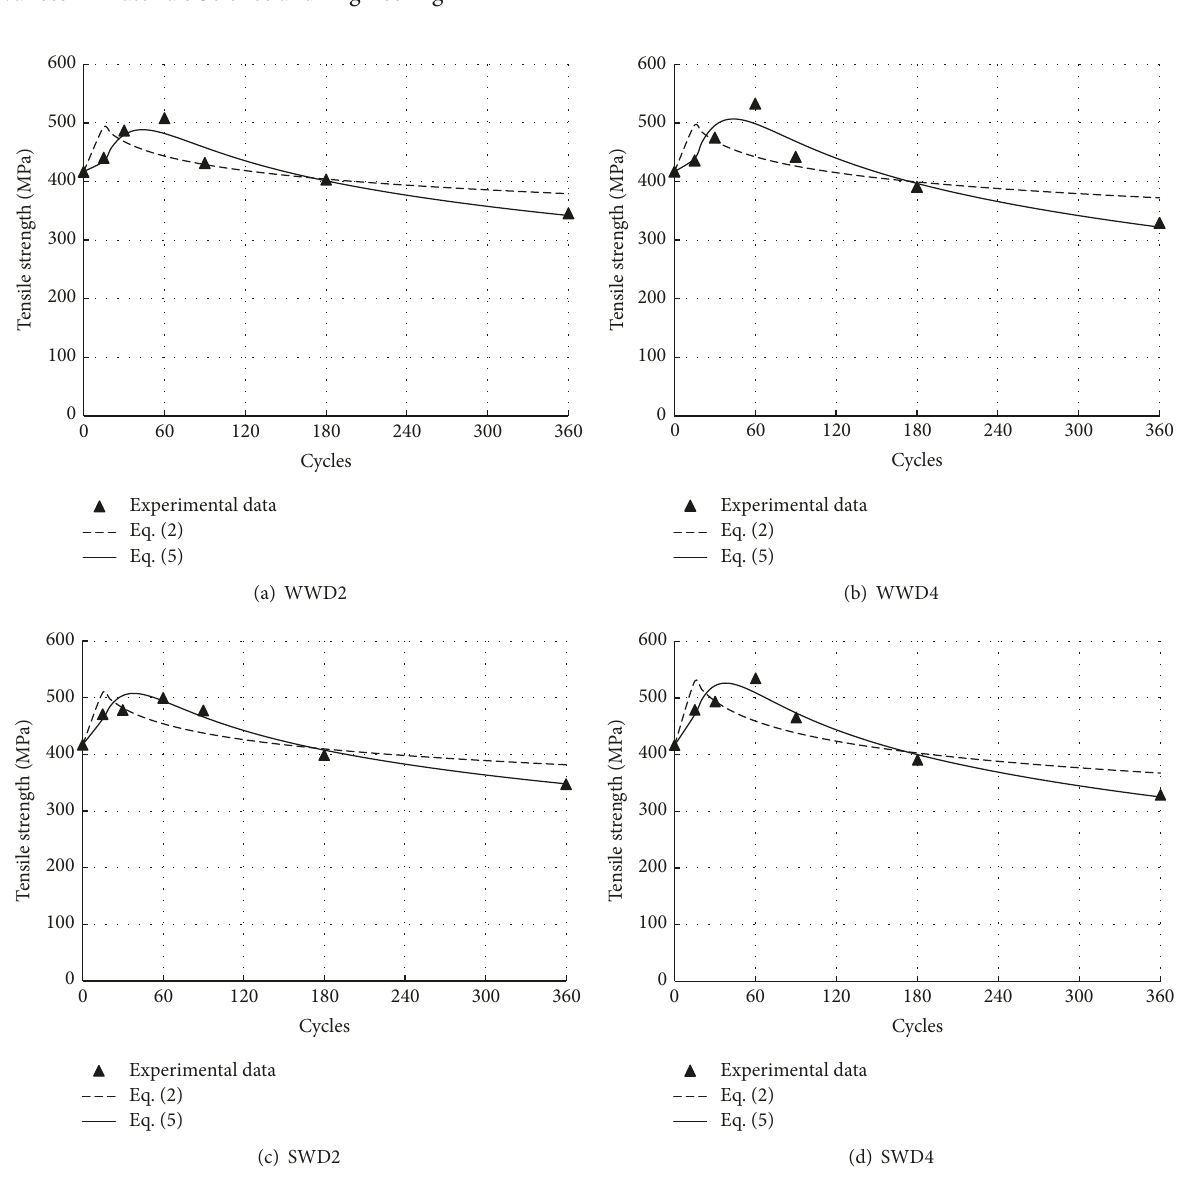
Figure 11: Comparison of prediction of tensile